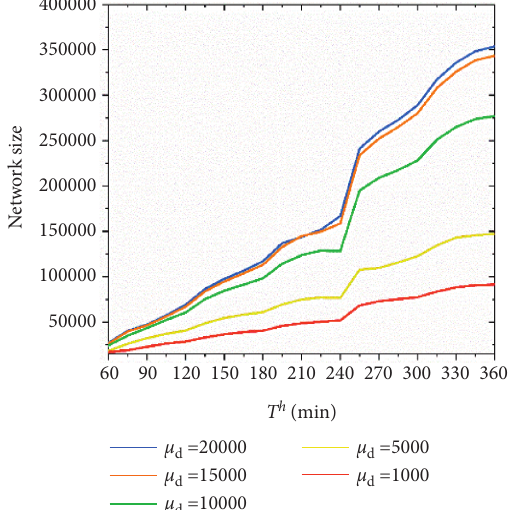
Figure 17: Results of network size with different distance limits.